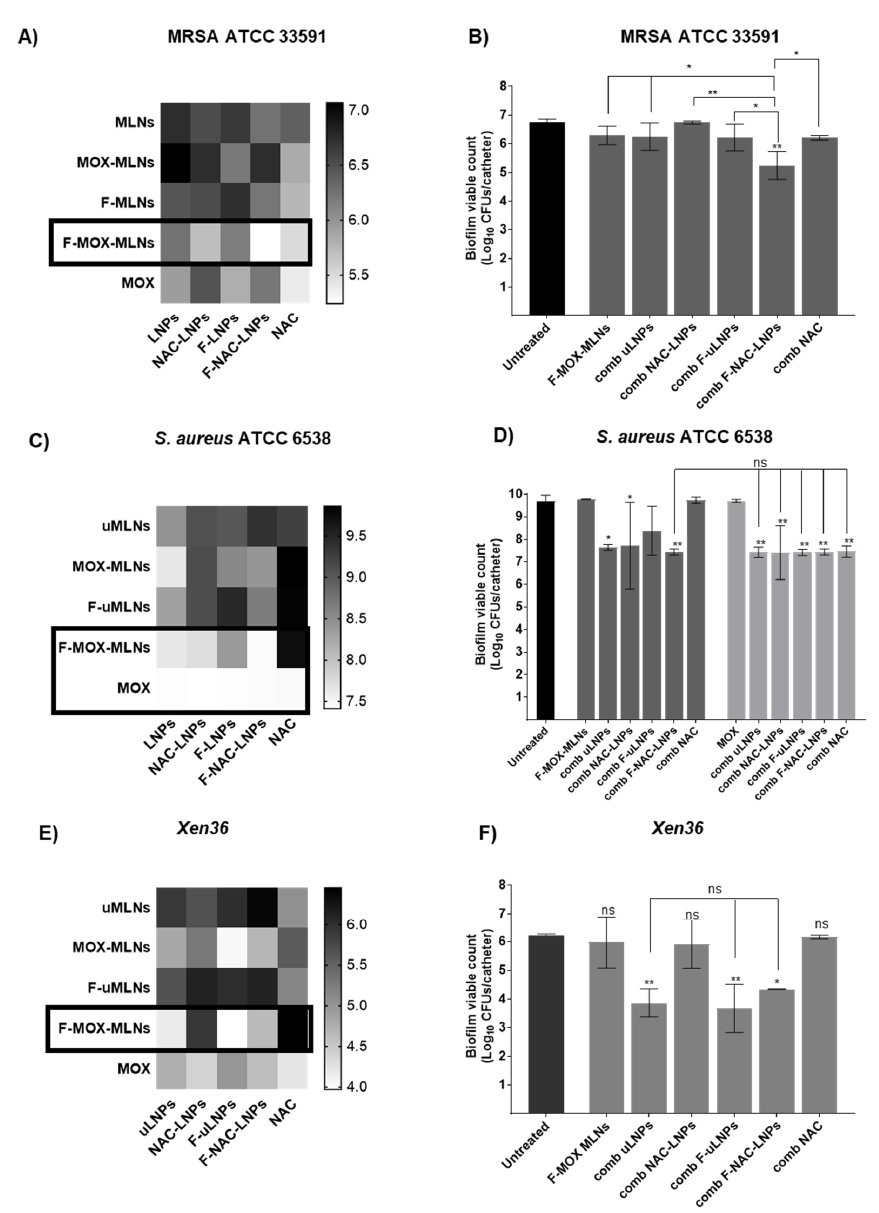
Figure 8. Biofilm viable count of ( A,B ) MRSA ATCC 33591, ( C,D ) S. aureus ATCC 6538, and ( E,F ) Xen36 biofilms grown in vitro in catheters after treatment with the combined nano therapy. ( A,C,D ) Heat maps represent the effect of the combination of MOX- and NAC-loaded nanosystems on the biofilm viable count. The treatment combinations with lower viable counts are highlighted (black squares). ( B,E,F ) F-MOX-MLNs (dark grey) and free MOX (light grey) (0.5 µ g mL − 1 ) alone and in combination with NAC-loaded nanosystems (comb uLNPs, comb NAC-LNPs, comb F-uLNPs, and comb F-NAC-LNPs) or free NAC (comb NAC) at a solid lipid concentration of 2 mg mL − 1 (corresponding to a NAC concentration of 0.9 mg mL − 1 ). Untreated biofilms were used as a positive control, and TSB 0.6x supplemented with 0.2% ( w / v ) glucose was used as a negative control. The values are presented as the mean ± SD for three catheters. * p < 0.05, ** p < 0.01, relative to the untreated biofilms. ns, not significant; * p < 0.05, ** p < 0.01. Statistical analysis: one-way ANOVA, Tukey’s multiple comparisons